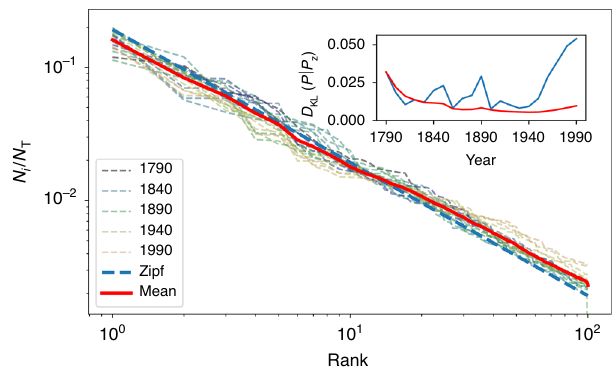
Fig. 4 The dynamics of the rank-size distribution for cities in the US between 1790 and 1990. Population structure distributions for the largest 100 cities in the US 53 are shown as dashed lines, while the average over all years is shown in red. The inset depicts the D KL ( P ∣ P z ) to Zipf ’ s law of the population structure for each available year (blue) and of the cumulative average over all structure vectors up the speci fi c year (red). We see that the temporal average steadily approaches Zipf ’ s law as more years are added. After an initial phase, the average is always closer to Zipf ’ s law than the distribution in any single year. Note that in recent decades, the population structure vector began consistently deviating from Zipf ’ s law, leading also to a small divergence of the cumulative temporal averages. This effect is to a large extent the consequence of mid-sized and large metropolitan areas growing faster over this period than the largest cities in the US urban